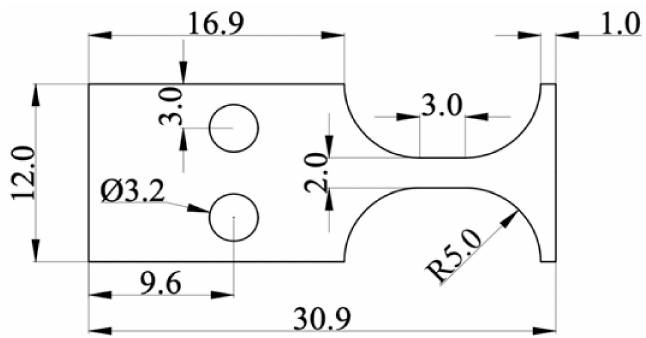
Figure 2. Sketch of ultrasonic symmetrical bending fatigue specimen (dimensions in